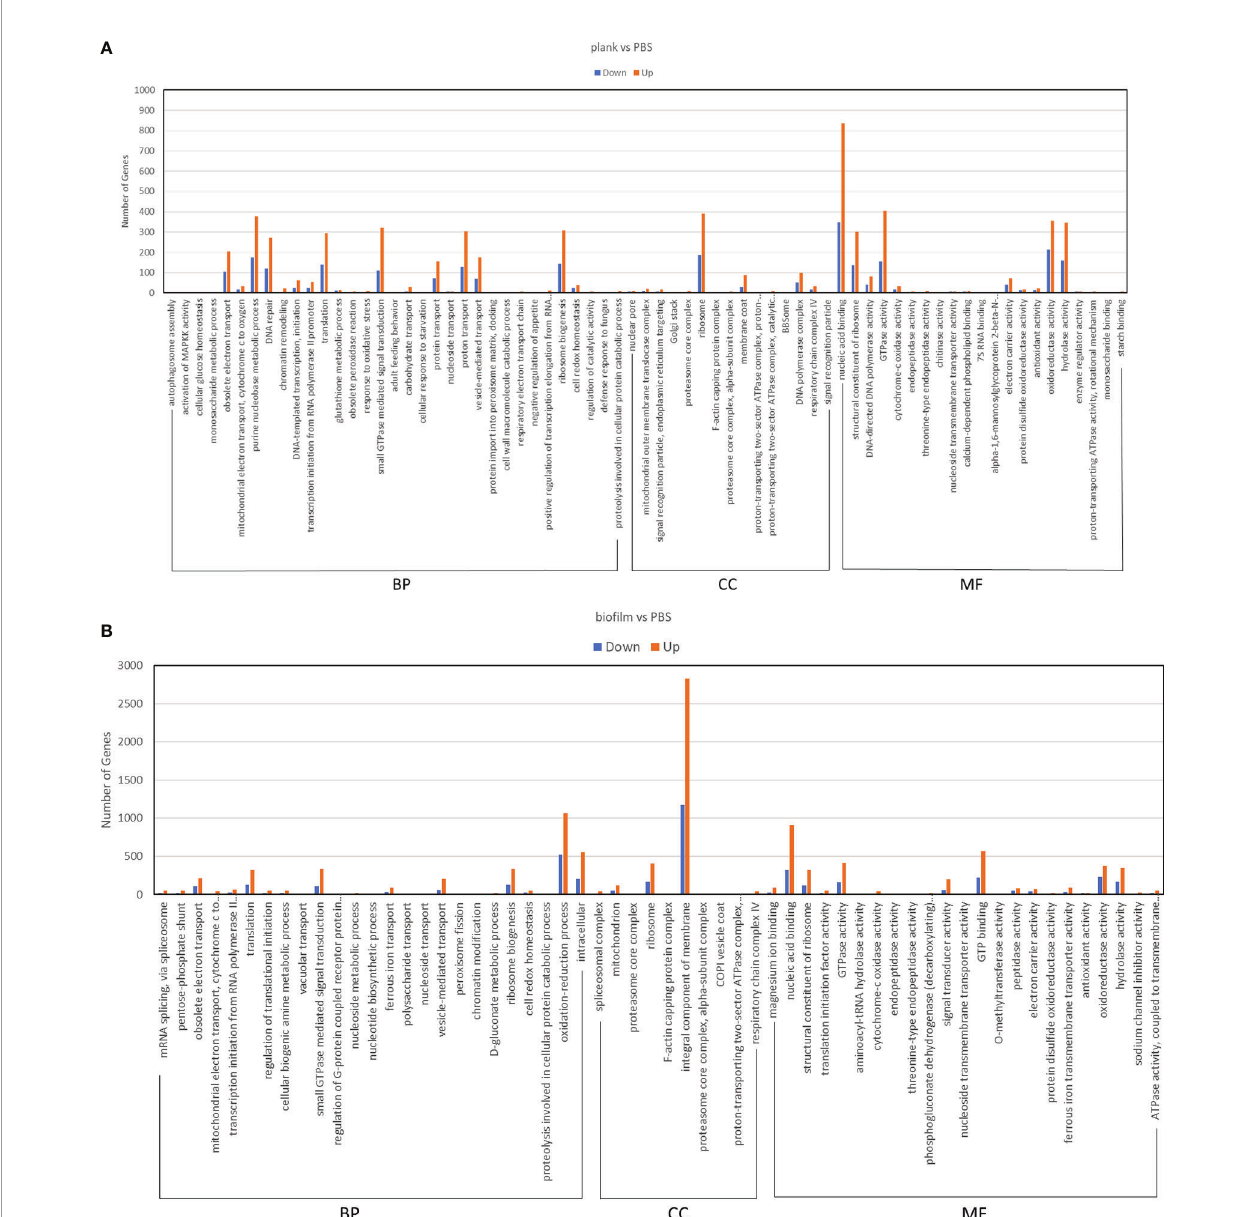
FIGURE 4 | GO enrichment analysis of DEGs in Lactococcus garvieae planktonic- and bio fi lm-infected mullets. GO analysis was divided into three categories: biological process (BP), cellular component (CC), and molecular function (MF). (A) plank group; (B) bio fi lm